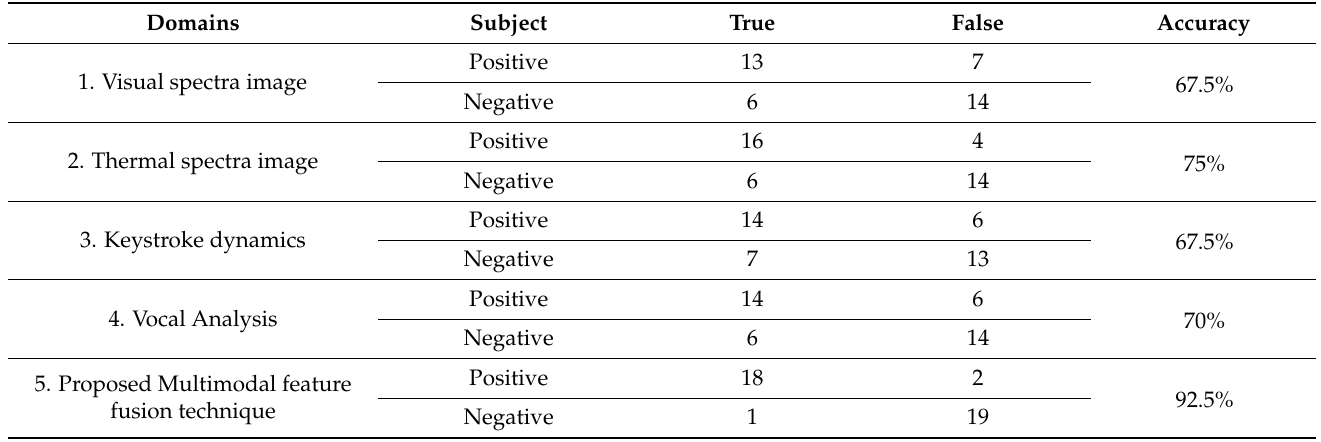
Table 7. Detection accuracy matrix from the individual and multimodal domains.